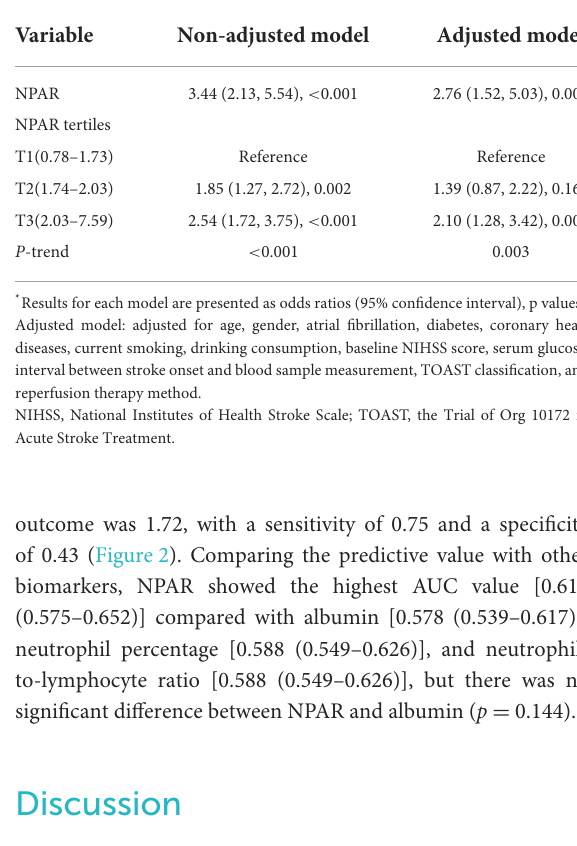
TABLE 3 Multivariate logistic regression analysis between admission NPAR and poor outcome * .